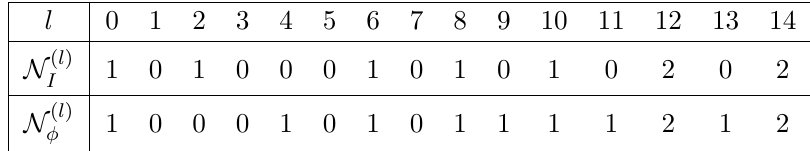
Table 1 . Dimensionalities N ( l )